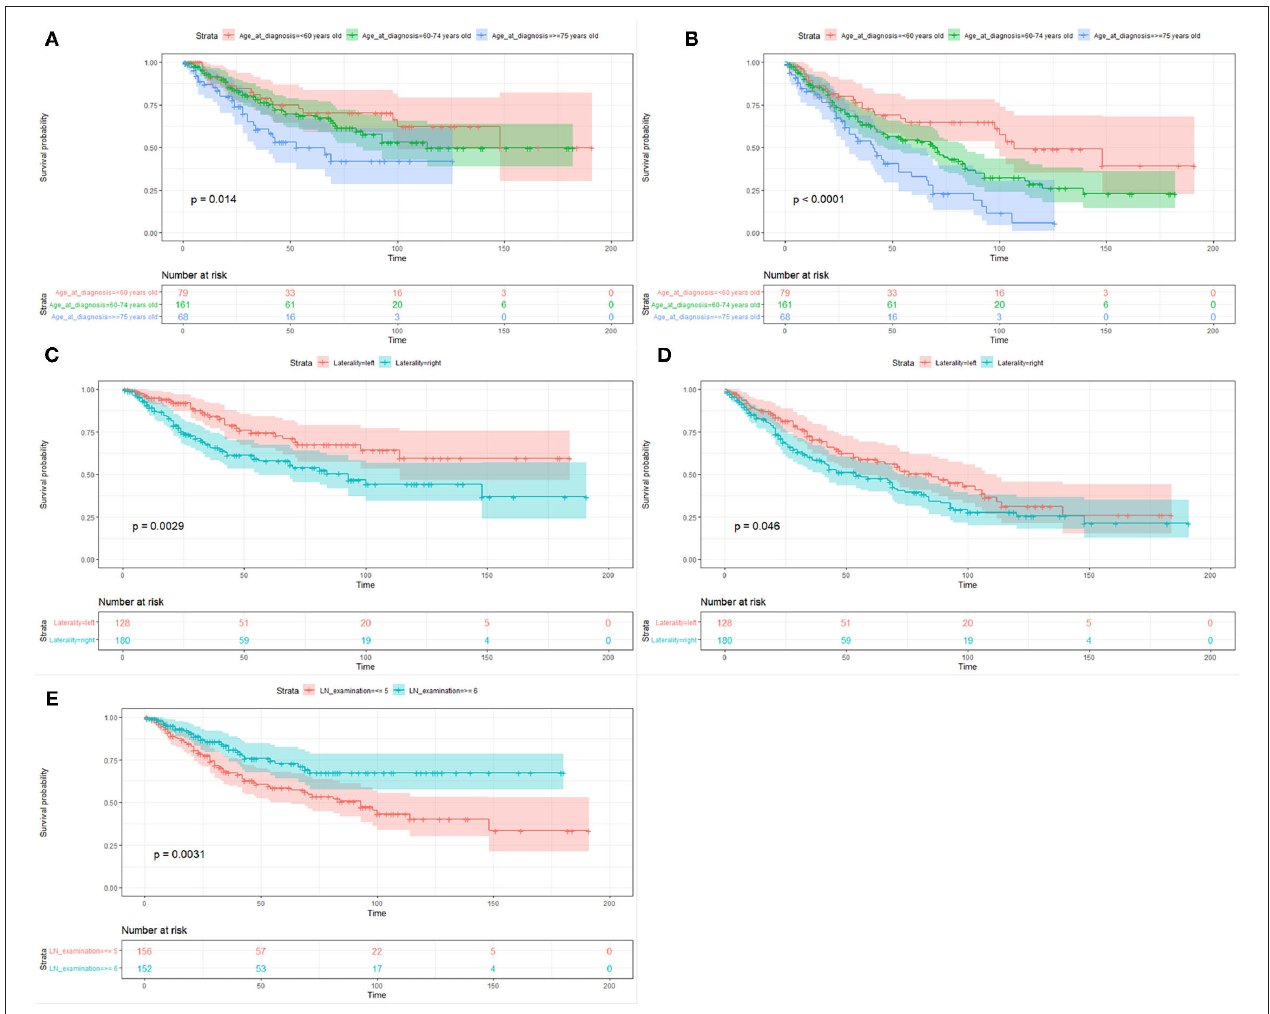
FIGURE 3 | Kaplan–Meier survival curves of cancer-specific survival (A,C,E) and overall survival (B,D) based on age at diagnosis, laterality of tumor, and the number of lymph nodes dissection.